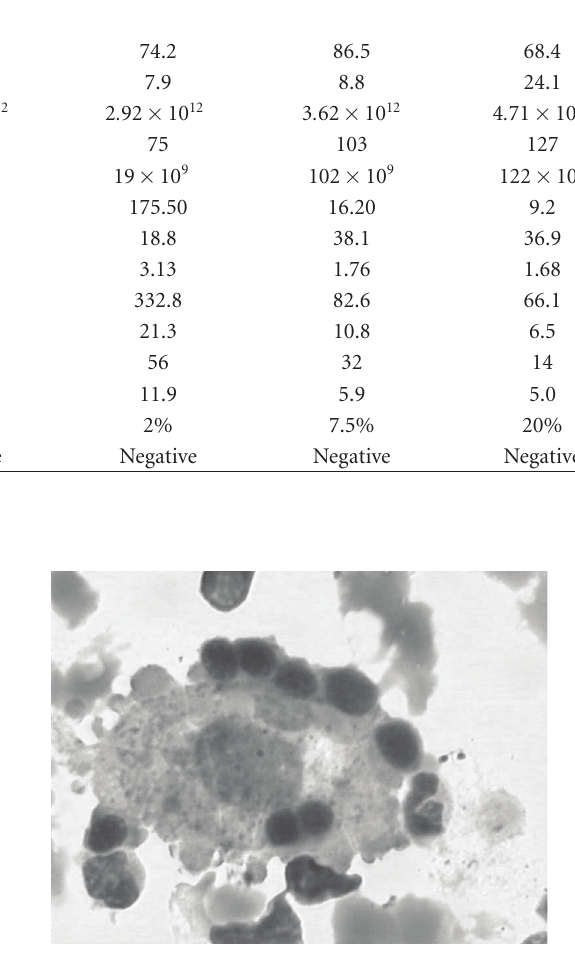
Figure 1: Bone marrow smear showed clasmatocytes engulfing blood cells (Wright’s staining, 10 ×